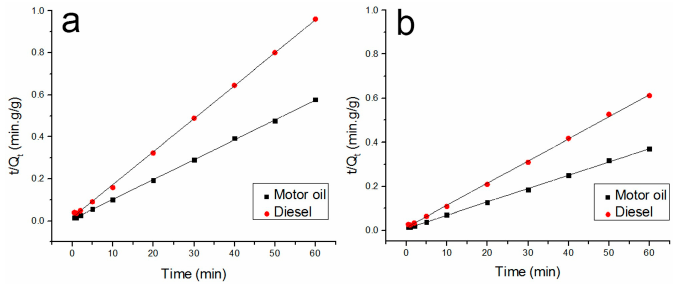
Figure 12. Linear fitting curve of the second-order kinetic law of the Lagergren model (( a ) raw PLA fiber; ( b ) (8% H203)/PLA fiber).